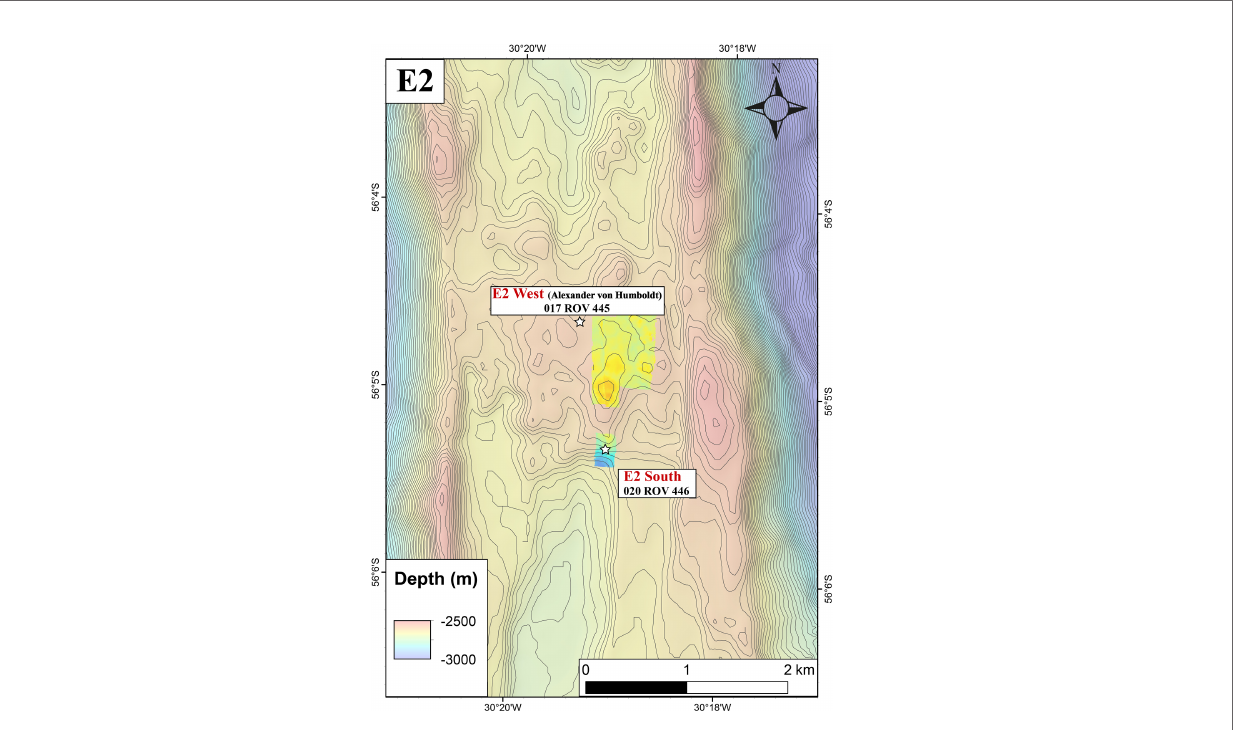
FIGURE 2 | Ship based bathymetry of E2-Segment of the ESR along with the indicated two sites E2-West and